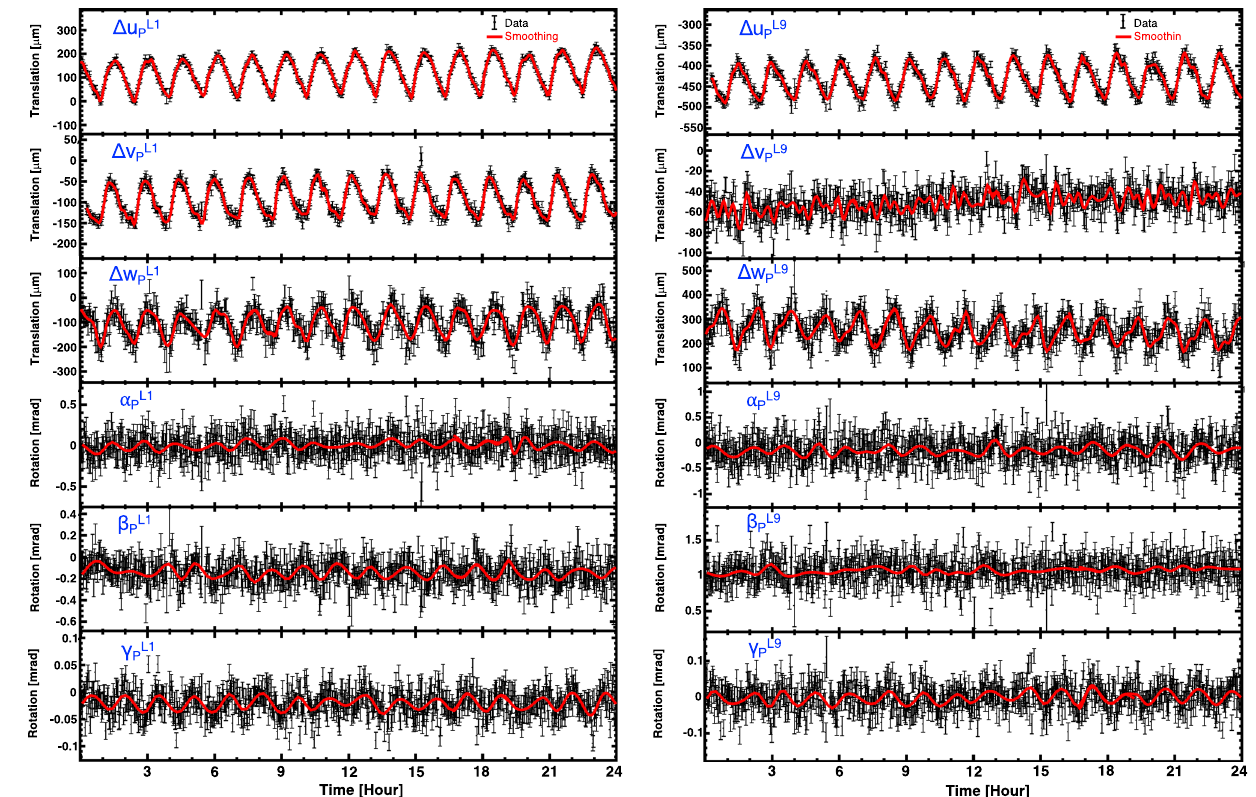
Fig. 15 The variations of the dynamic alignment parameters of L1 (left column) and L9 (right column) over 24h on Dec. 17,